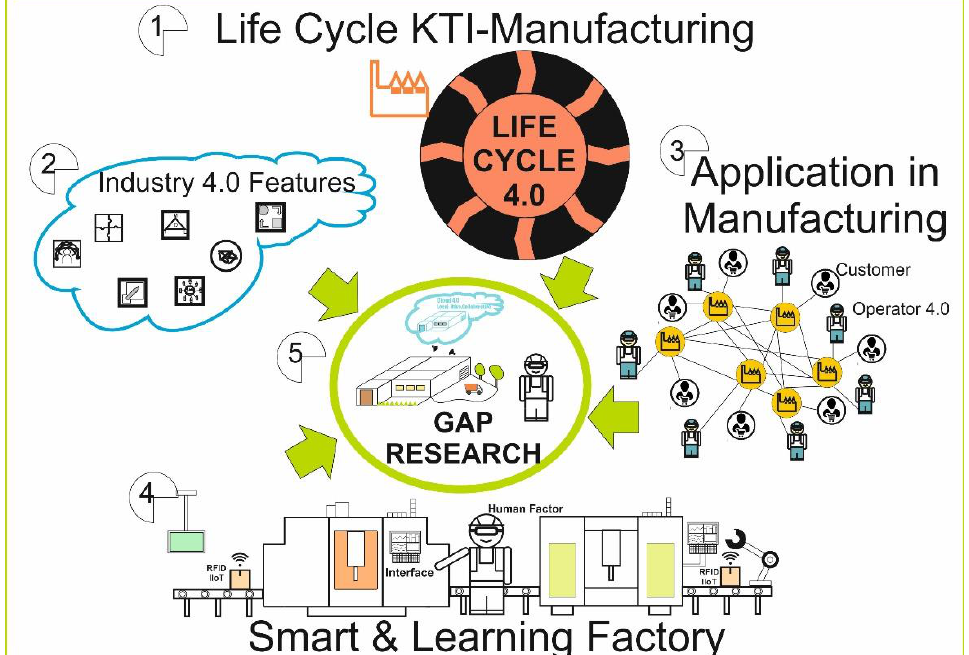
Figure 1. Background of the literature organisation.